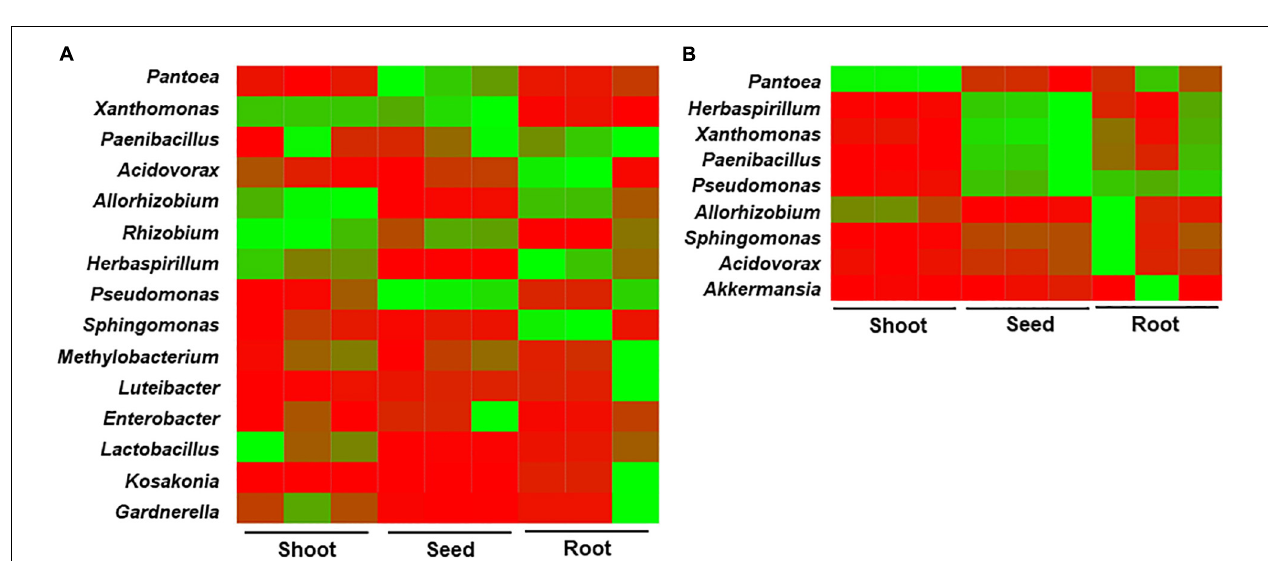
FIGURE 5 | Heat map analysis of bacterial composition in rice seeds at species level. The bacterial community structure of the variety Shindongjin was compared between rice seeds that are sampled (A) , at 20 days after heading (dah); (B) , 4 months after storage (mas) at 4 and 15 ◦ C; and (C) , seed remains after 10 days of germination of 6-month-old seeds.